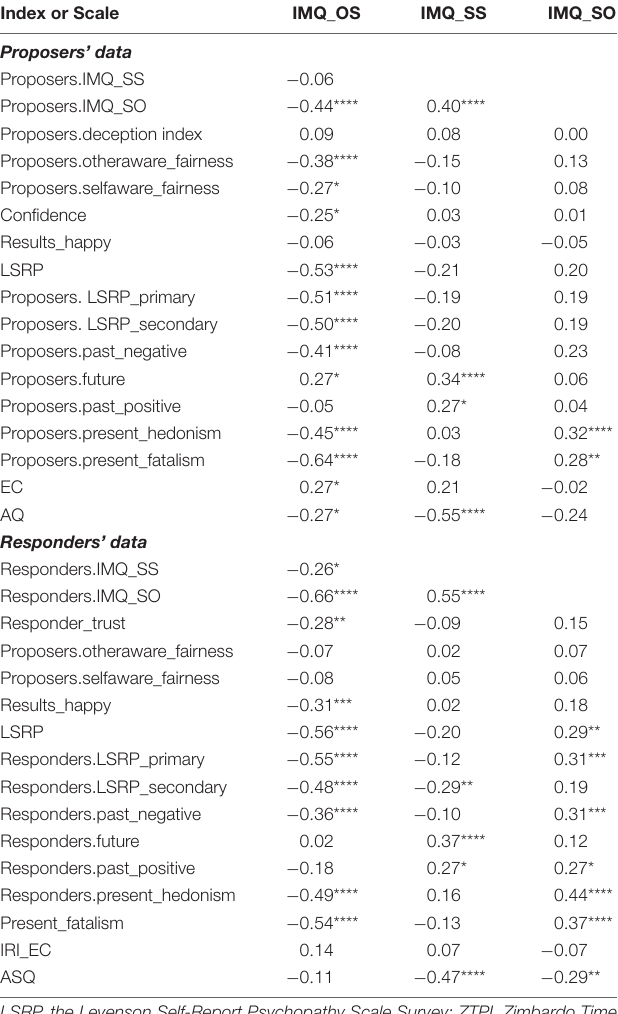
TABLE 4 | Correlations of IMQ subscales with other measures: Sample